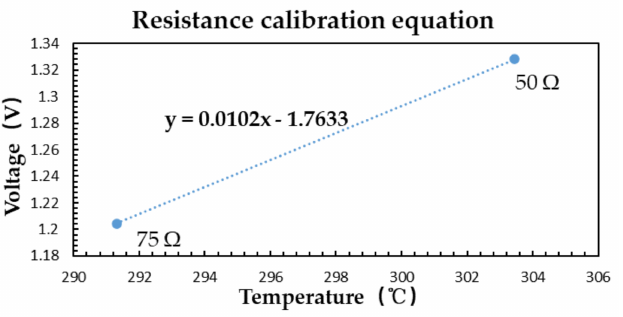
Figure 23. Calibration curve of microwave load.